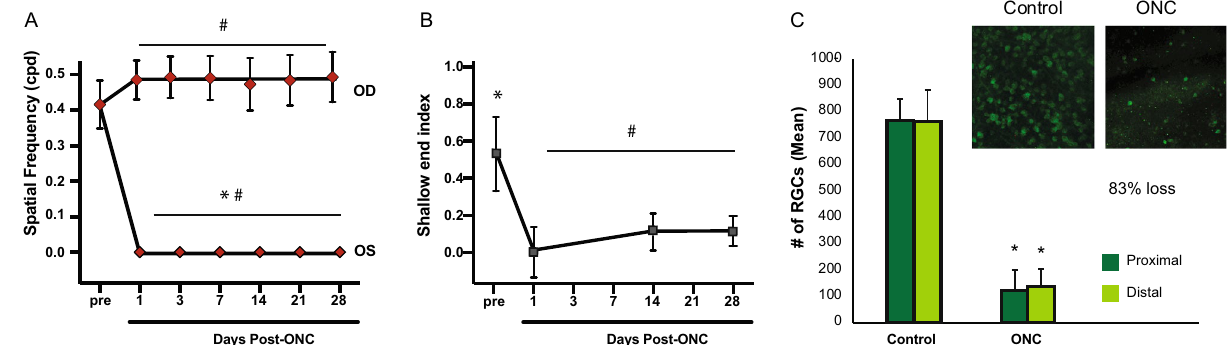
Figure 5. Effect of ONC on visual acuity and retinal cell loss. (A) Following the optic nerve injury in the left eye (day 1 -28), there was a significant decrease in visual acuity of the injured eye and a slight increase of visual acuity of the intact eye when compared to the baseline values. ( B) Following the optic nerve injury (day 1 -28), there was a significant decrease in depth perception, which induced a decrease in time spent in the shallow end with no significant recovery. ( C) The ONC induced a severe loss of retinal ganglion cells (83–90%) both in central (proximal, dark green) and peripheral (distal, light green) regions of the retina. Insert: microphotographs of flat mount retinas stained with RBPMS, showing the 17% survival of the RGC (after bilateral ONC). (*) Indicates Wilcoxon test, between condition (A,C) or between shallow and deep end (B) and which provided p values under 0.05. (#) Indicates Friedman test, between baseline and current day and which provided p values under 0.05. ONC optic nerve crush, OD right eye (oculus dexter), OS left eye (oculus